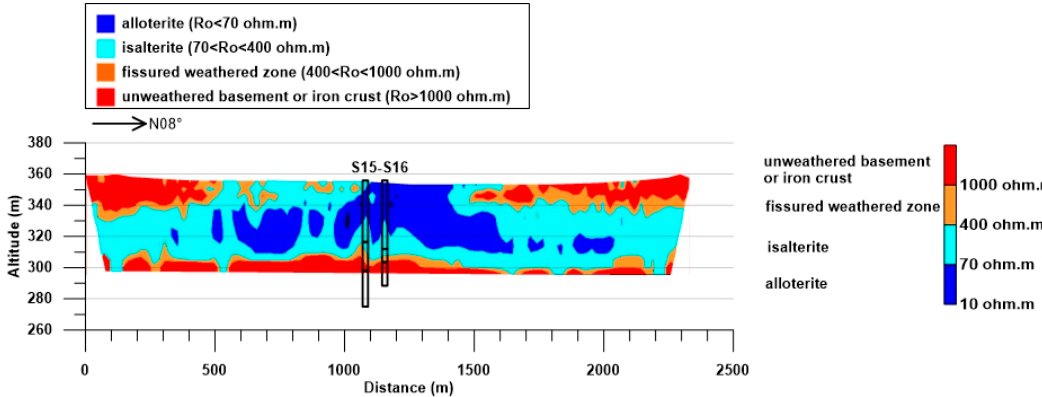
Figure 3. Profile 2: geological model showing different parts (and related electrical resistivity values) of the weathering profile and well-test location (modified from Soro et al. [8]).